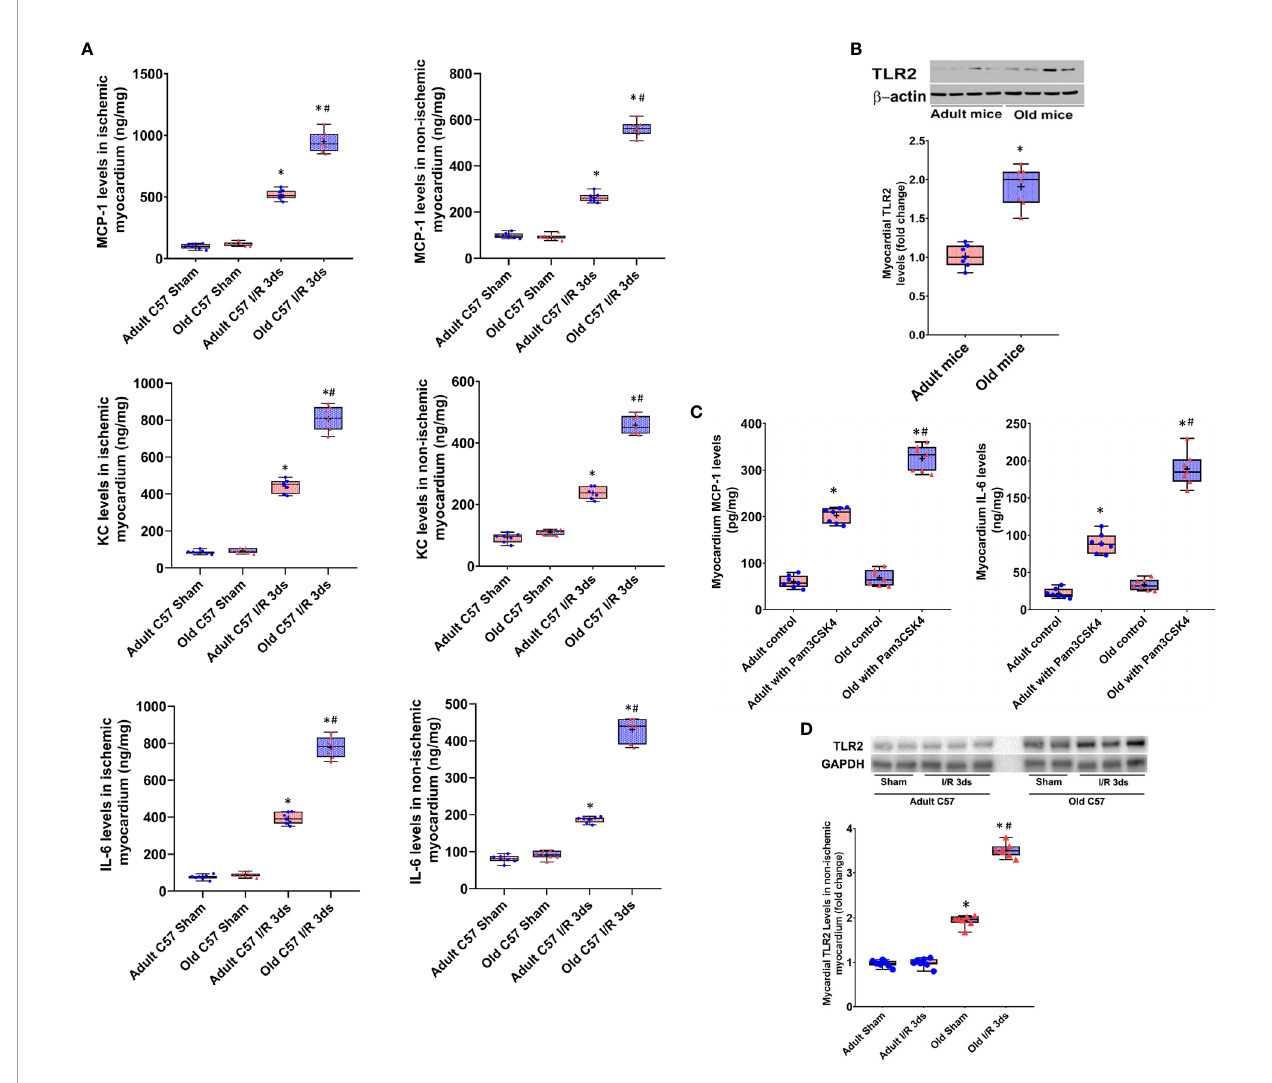
FIGURE 1 | Myocardial hyper-in fl ammatory responses in old mice are associated with elevated Toll-like receptor (TLR) 2 levels in the heart. (A) Levels of monocyte chemoattractant protein 1 (MCP-1), keratinocyte chemoattractant (KC) and interleukin-6 (IL-6) in ischemic (left column) and non-ischemic (right column) myocardium were analyzed at day 3 of reperfusion after 30 minutes of myocardial ischemia induced by left anterior descending artery occlusion. While levels of these in fl ammatory mediators were increased in the myocardium of both adult and old mice, old mice displayed greater increases in both ischemic and non-ischemic myocardium. N = 7 in each group, *P < 0.05 vs. sham controls, # P < 0.05 vs. adult ischemia/reperfusion. (B) Immunoblotting and densitometric analysis revealed higher levels of TLR2 in the myocardium of old mice compared to adult mice. N = 7; * P < 0.05 vs. adult. (C) Adult mice and old mice were treated with speci fi c TLR2 agonist Pam3CSK4 (2.5 m g/g, iv). Old mice had greater levels of MCP-1 and IL-6 in the myocardium examined at 24 hours after treatment. N = 7; * P < 0.05 vs. saline control; # P < 0.05 vs. adult treated with Pam3CSK4. (D) Immunoblotting and densitometric analysis show that TLR2 levels in the non-ischemic myocardium of old mice at day 3 after I/R are greater than control (sham) levels while they are comparable to controls (sham) in adult mice at day 3 after I/R. N = 7; * P < 0.05 vs. adult with the same treatment. # P < 0.05 vs. old sham. In (A – D) , data are presented as box-and-whiskers plots. The upper and lower borders of the box represent the upper and lower quartiles. The upper and lower whiskers represent the maximum and minimum values of nonoutliers. The horizontal line in the box represents the median, and the + sign represents the